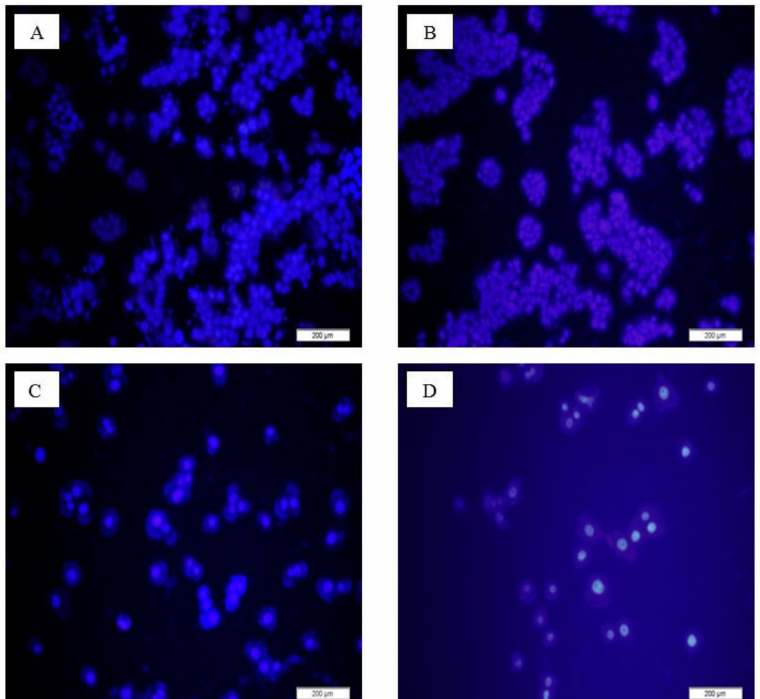
Figure 11. Morphological alterations of cancer cells. Hoechst 33258 staining showed morphological alterations such as shrinkage, loss of cell integrity, and chromatin condensation (( C , D ): HT-29 and MDA-MB-231) in comparison to untreated cells (( A , B ): HT-29 and MDA-MB-231).